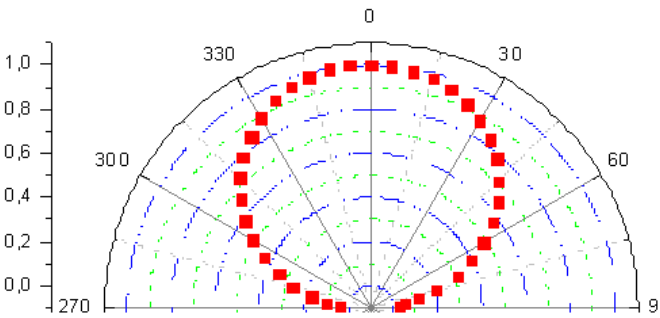
Figure 4. Radiation pattern of the emitter device.